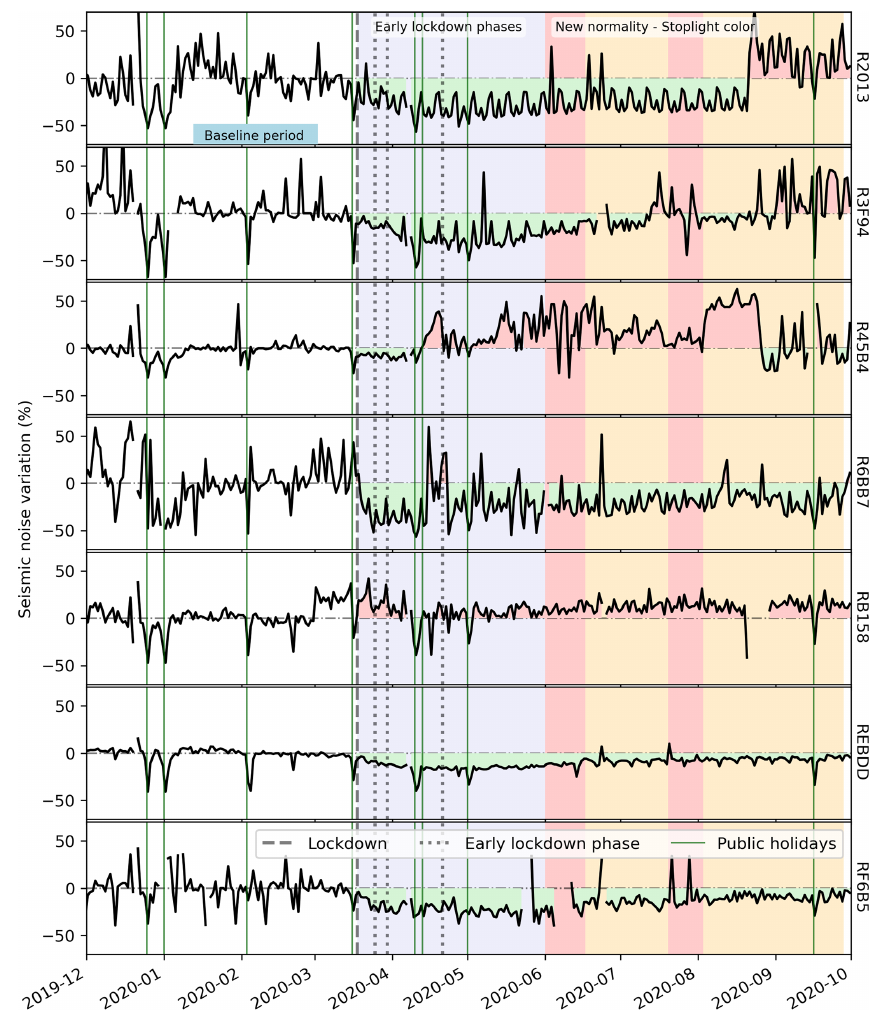
Figure 4. Variation of seismic rms between 4 and 14Hz in percent at all seven stations of the network relative to the median of the corre- sponding day of the week during the baseline period of 13 January to 2 March. The public holidays are indicated with green vertical lines, and the implementation of lockdown measures is indicated as the black dashed line. The purple span corresponds to the early lockdown phases, and the red and orange spans after 1 June are the corresponding stoplight color for the “new normality”.